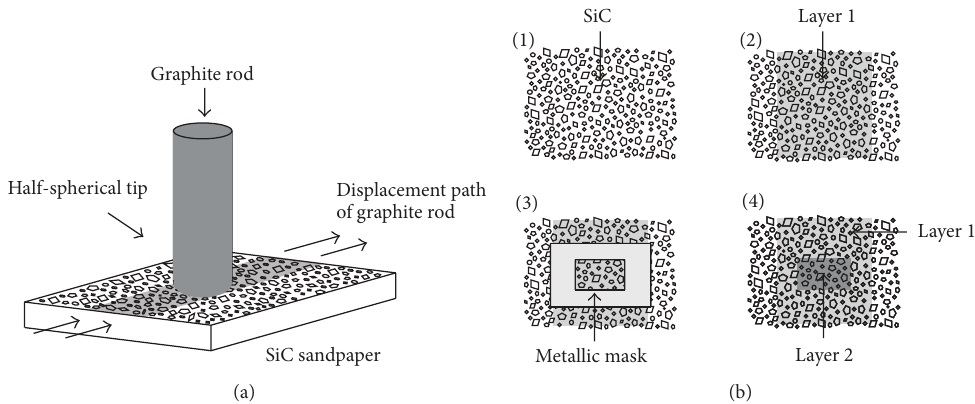
Figure 1: (a) Schematic of the reverse abrasion technique. (b) Four steps employed for assembling of the graphite layers.